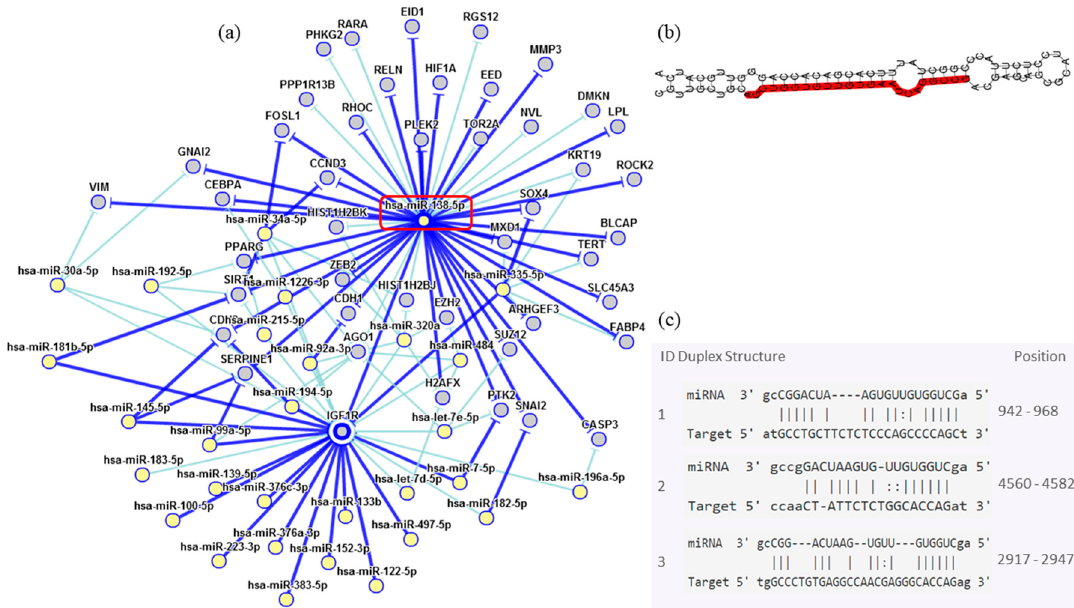
Figure 11. Interaction network of miR-138-5p. ( a ) The mRNA showed a strong modulation of IGF1R . ( b ) Molecular structure: pre-miRNA hairpin of miR-218-5p, second structure of pre-miRNA, and, in red, mature sequence 23|AGCUGGUGUUGUGAAUCAGGCCG|45. ( c ) miRNA sequence of target interactions with IGF1R showing the position in the gene sequence. Dark blue shows strong evidence (reporter assay, Western blot, qRT-PCR or qPCR), and light blue shows other evidence.